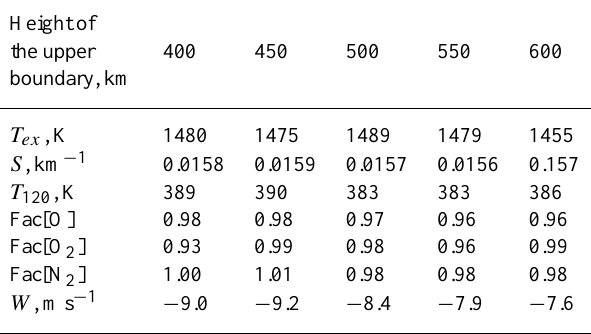
Table 1. Dependence of calculations on the upper boundary height specification for daytime conditions (13 UT). Vertical plasma drift W is given at 300 km. Factors for neutral concentrations are given with respect to MSIS-83 model values with T ex , S and T 120 shown in the table. Height of the upper 400